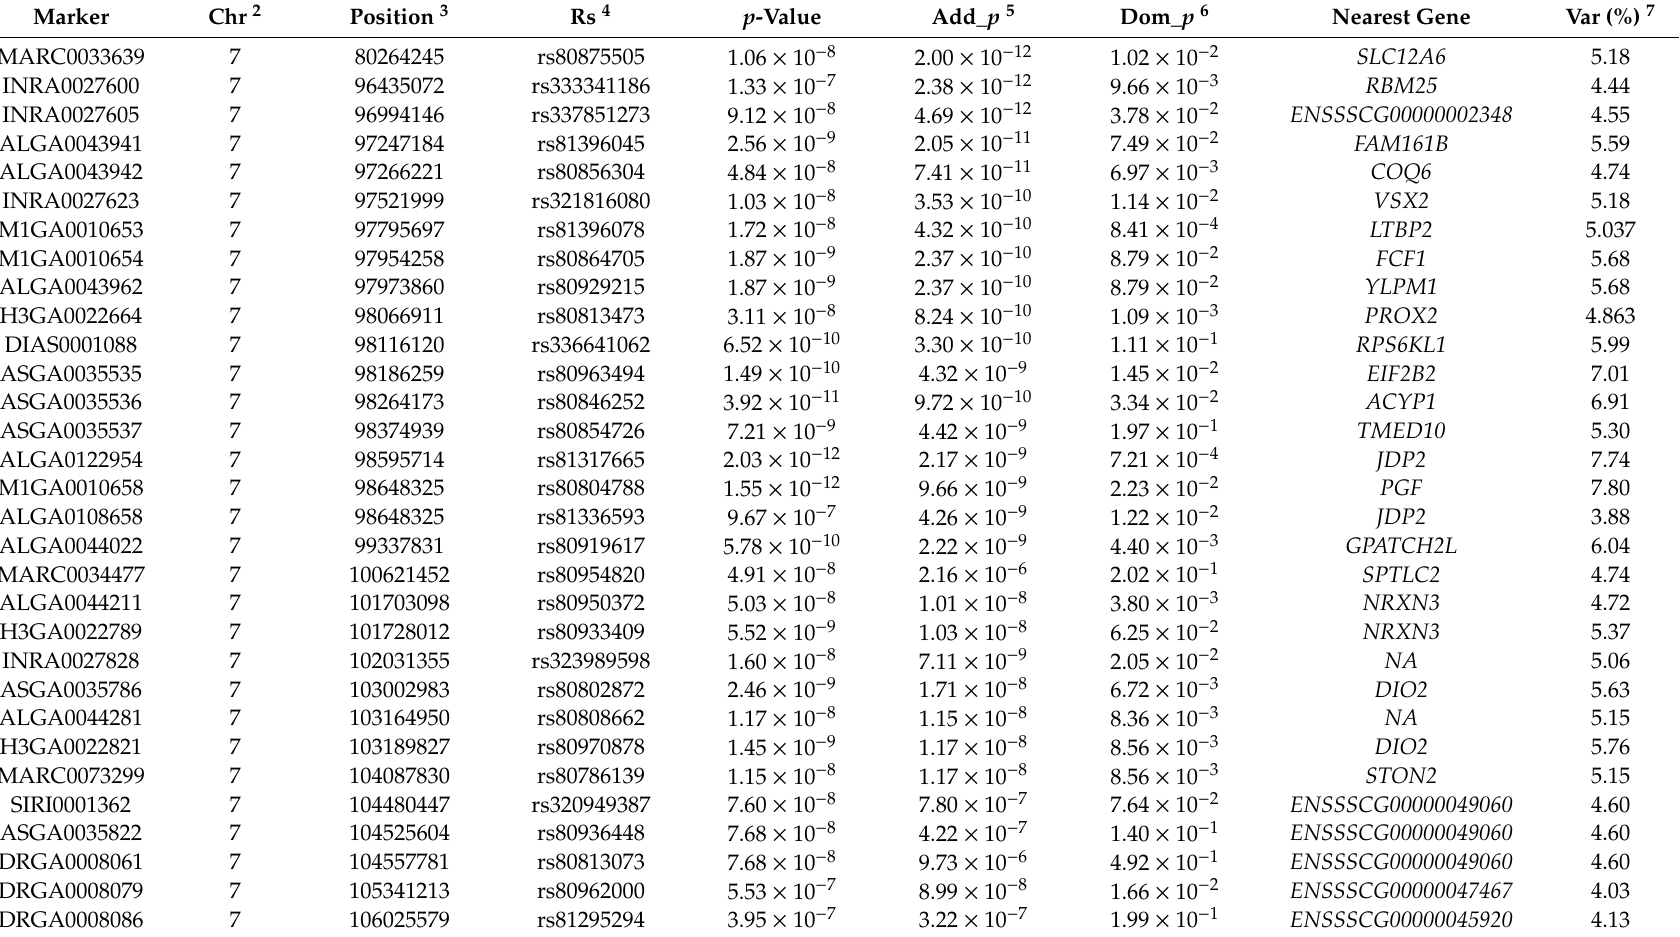
Table 2. Genome-wide association studies identified some associated variations for the NTV on SSC7 1